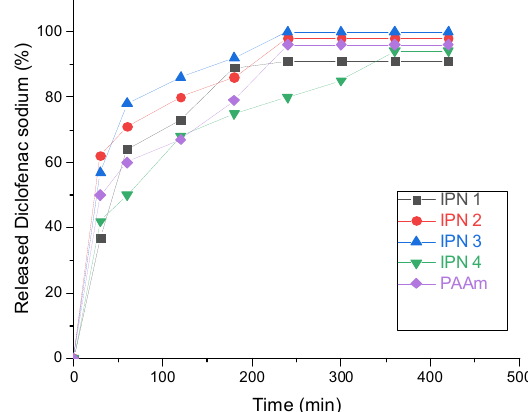
Figure 7. Drug release kinetics of diclofenac sodium at pH 6.8.